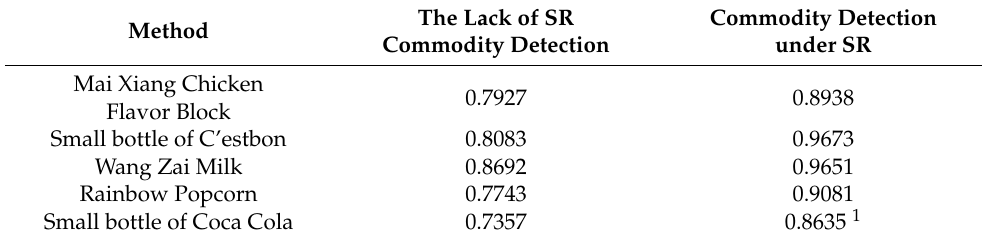
Table 5. Detection accuracy of original image and